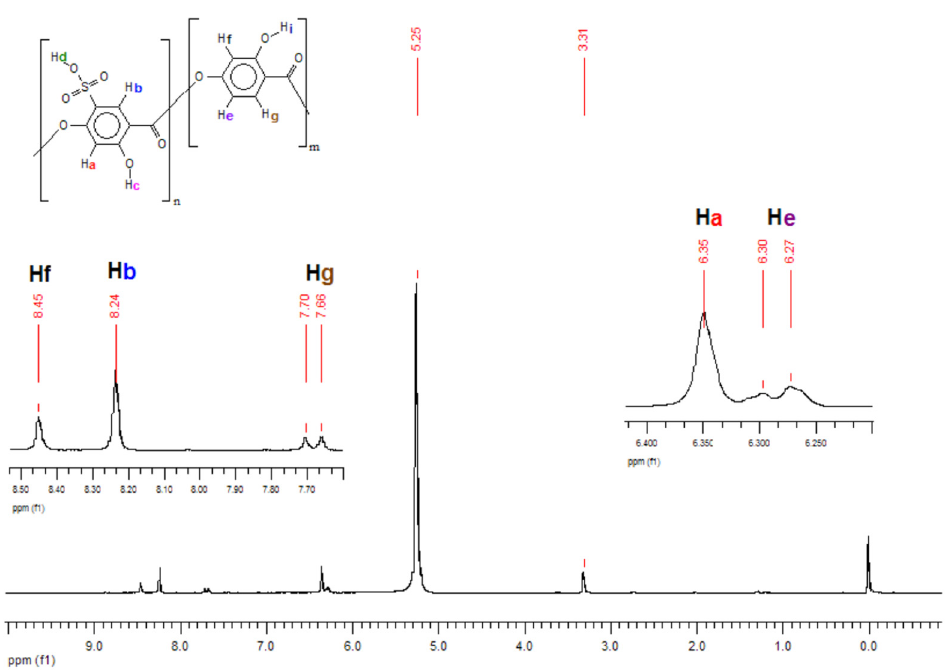
Figure 12. 1 H NMR spectra of poly(2,4-dihydroxy-5-sulfobenzoic acid).